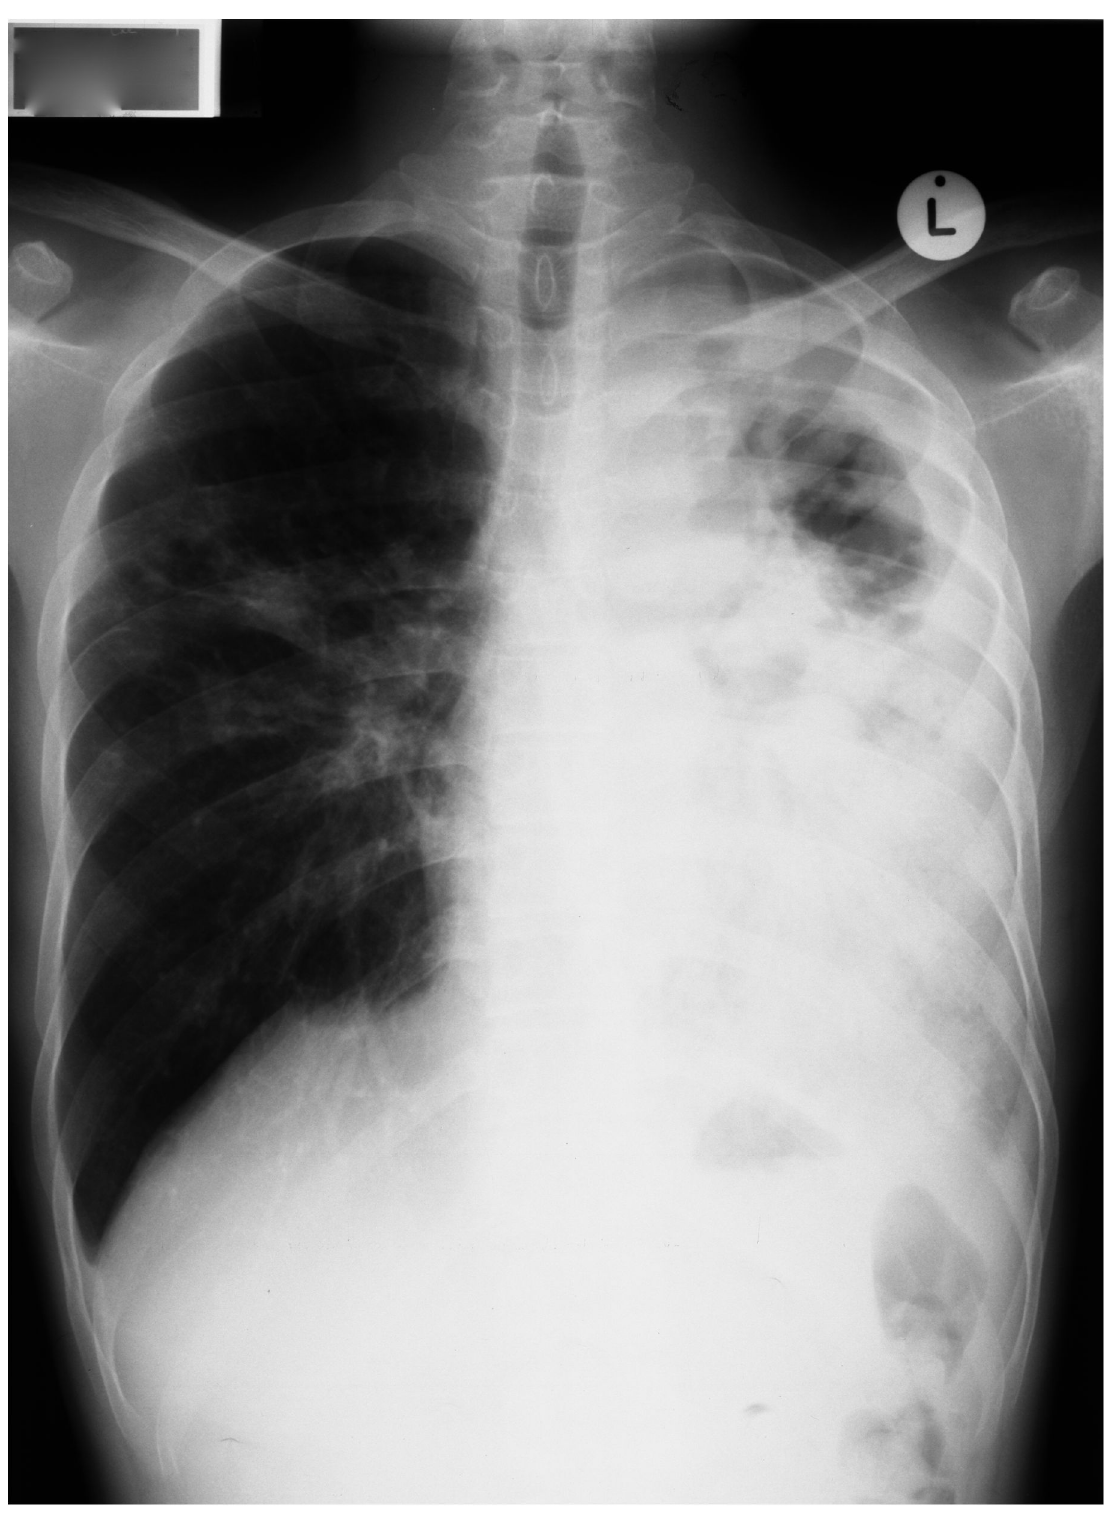
Figure 1. Chest radiograph showing left-sided pleural effusion, consolidation and both hilar and mediastinal lymphadenopathy.